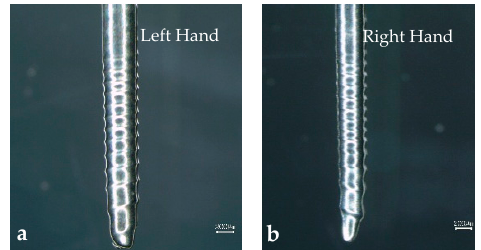
Figure 4. The spiral electrodes fabricated by different rotation directions.